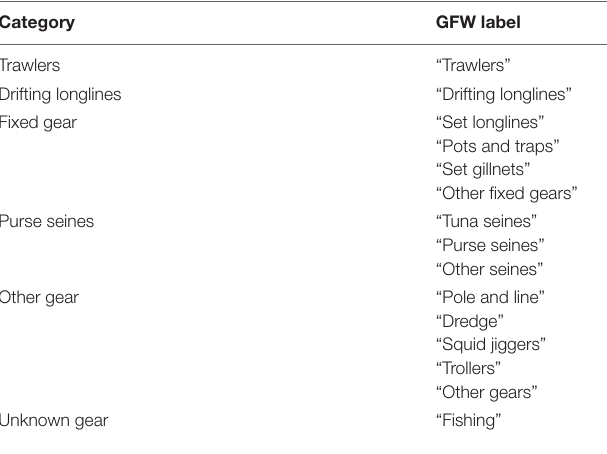
TABLE 1 | New categories based on categories assigned by the Global Fishing Watch